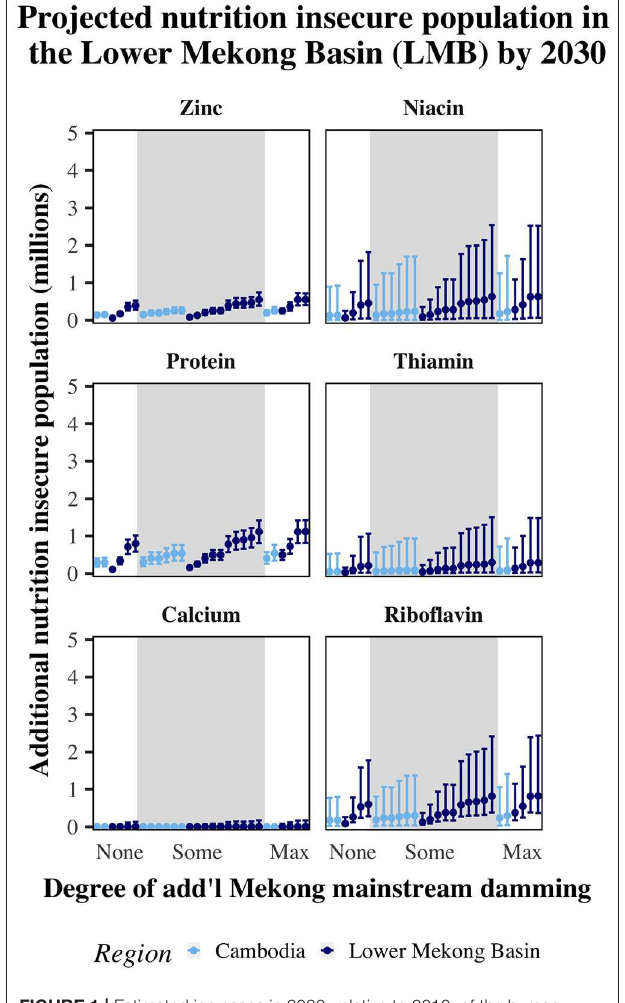
FIGURE 1 | Estimated increases in 2030, relative to 2010, of the human population classified as nutrition insecure (i.e., below the EAR cut-point) for zinc, protein, niacin, thiamin, riboflavin, and calcium, according to each damming scenario projection. We classified each damming scenario according to the extent of additional mainstream damming (“none,” “some,” or “max”) which corresponds to 0, 1–9, and 11 additional dams. The white and gray panels break the bars into these categories. The error bars represent the 95% confidence interval for each scenario.